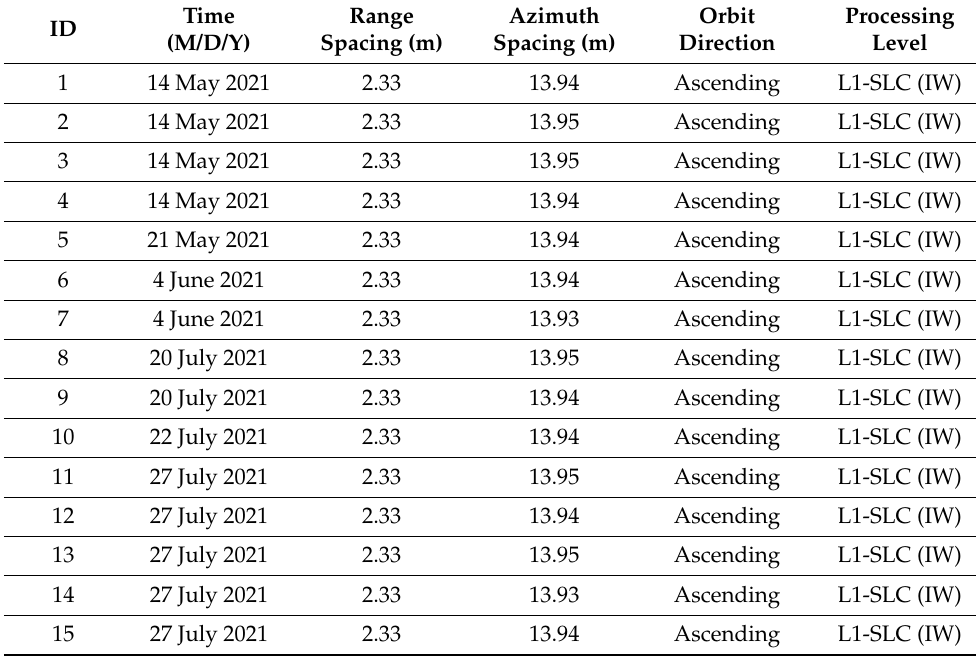
Table 1. Parameters of Sentinel-1A SAR